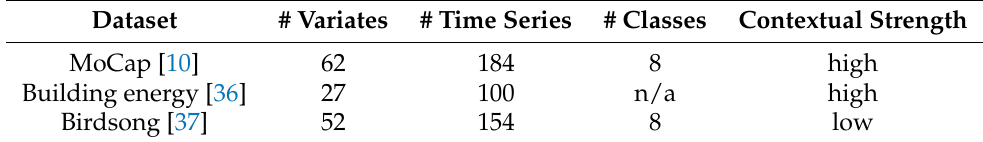
Table 1. Characteristics of the